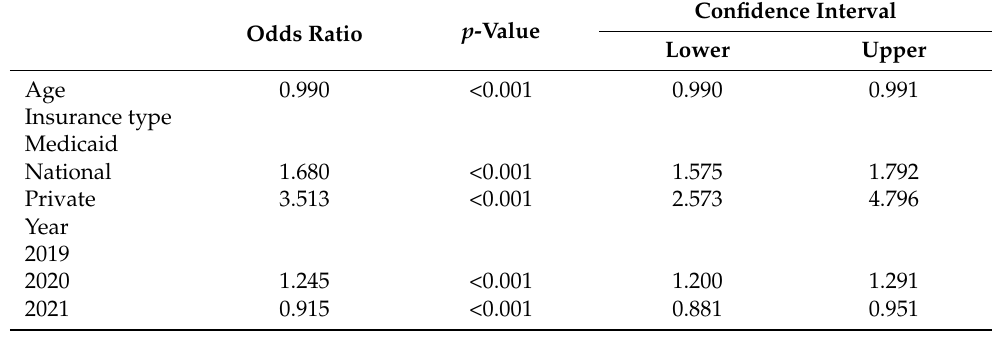
Table 3. Logistic regression of sociodemographic data for cancellation rate. Odds Ratio p -Value Confidence Interval Lower